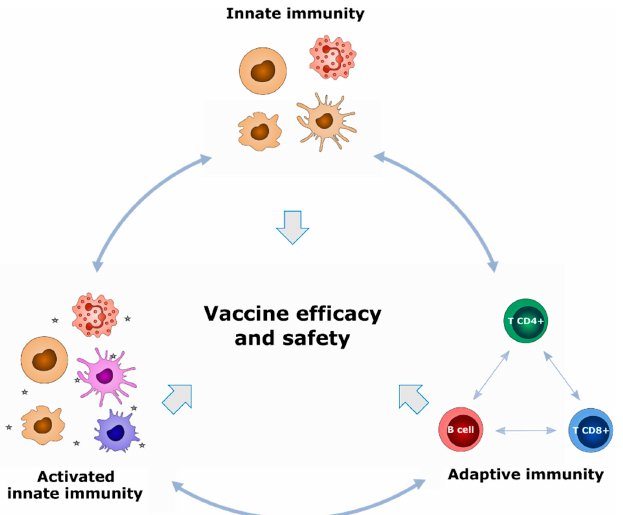
Figure 1. Vaccine efficacy and safety are determined by interactions between innate and adaptive immunity. These interactions are shaped by host factors and can be orientated by vaccine proper- ties.